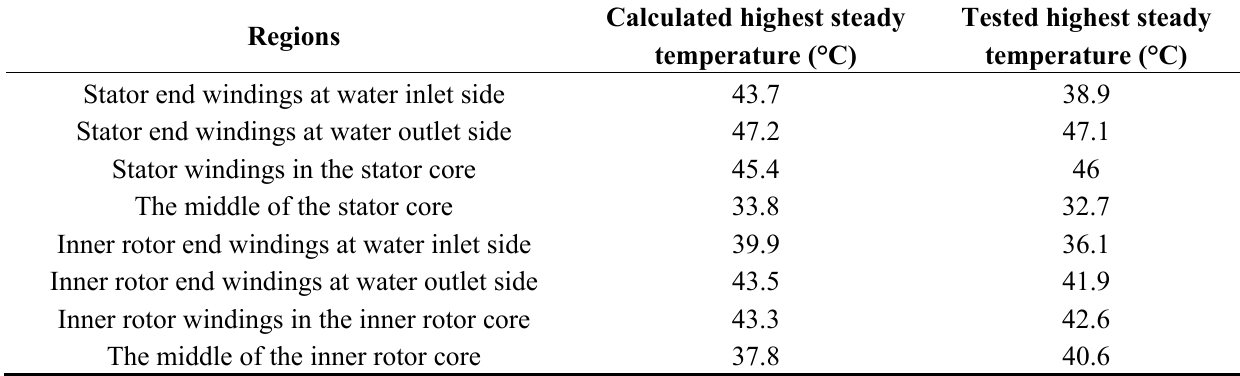
Table 16. Calculated and tested highest temperatures in the prototype when the SM and DRM run at rated torque and low speed, and water cooling and forced air are used in the